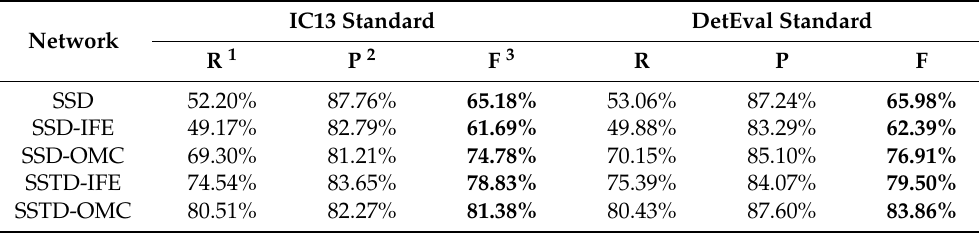
Table 1. Comparison of the IFE and outside mutual correction (OMC) algorithms (on ICDAR2013).